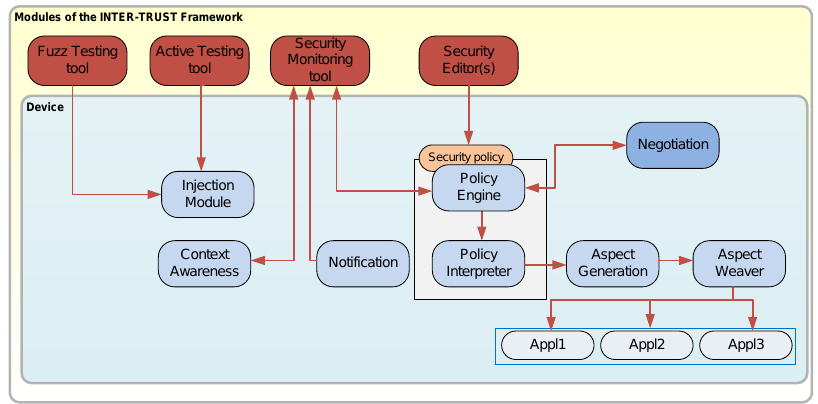
Figure 2. The INTER-TRUST